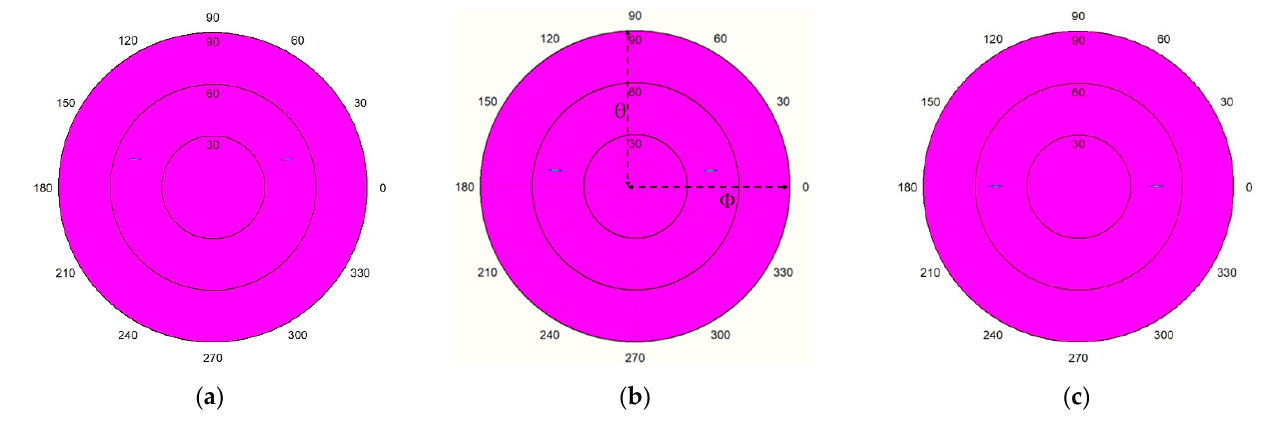
Figure 10. Changing the input wavelength and using FDTD to calculate the FFP intensity of the antenna in the theta direction. ( a ) For the input wavelength of 1510 nm, the beam is shifted to the 15-degree angle position. ( b ) For the designed center wavelength of 1550 nm, the beam is moved to 8.4 degrees. ( c ) For the input wavelength of 1600 nm, the beam is shifted to − 0.8 degrees.